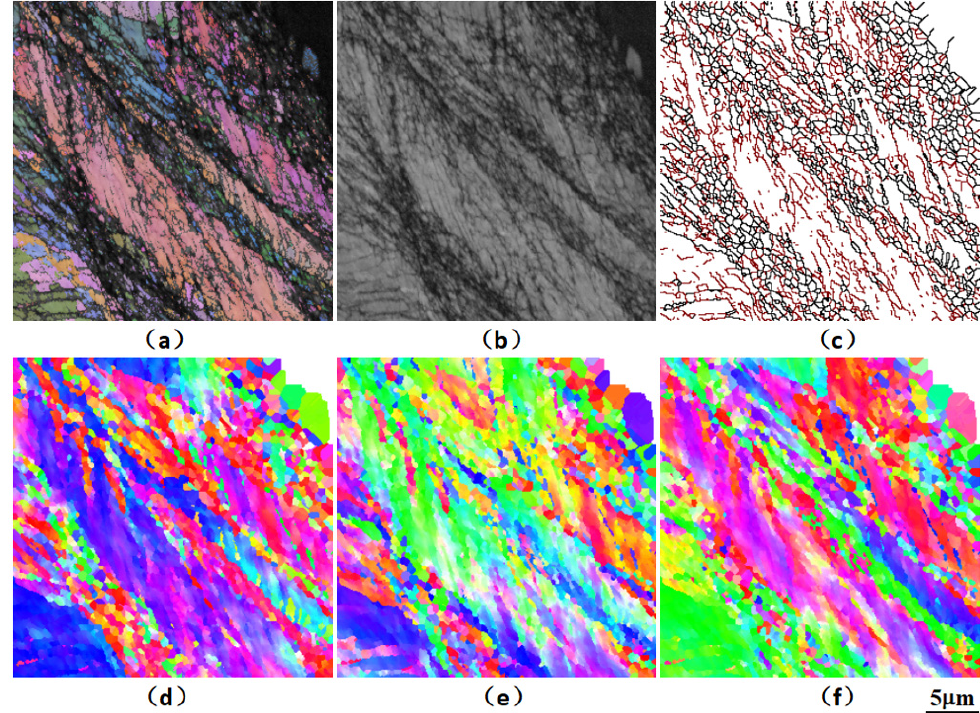
Figure 17. EBSD analysis results of microstructure near the fracture surface of the fatigue failure specimen of the SLM HEA (the detection area is the white solid frame area in Figure 16a): p.( a ) comparison of all Euler diagrams and diffraction bands, ( b ) diffraction band comparison chart, ( c ) large angle (>15° black line) and small angle (<15° and >5° red line) grain boundary diagram, ( d ) IPF_X inverse pole figure, ( e ) IPF_Y inverse pole figure, ( f ) IPF_Z inverse pole figure.